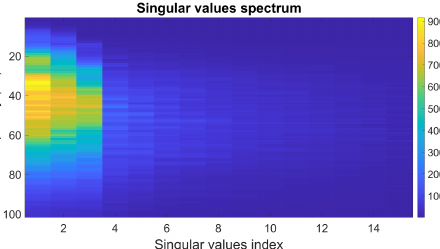
Figure 3. Singular-value spectrum. The color bar represents the magnitude of the singular